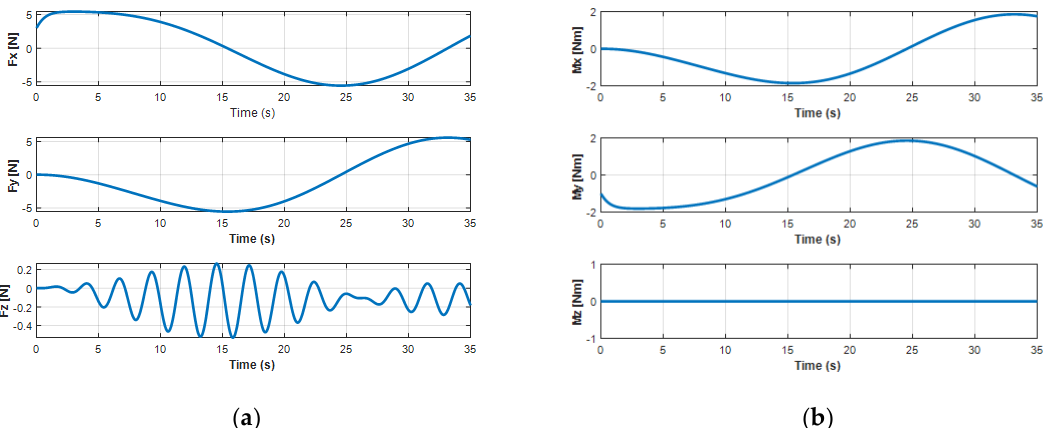
Figure 17. Cable forces and moments affecting UUV turning motion: ( a ) forces of the UC on the UUV; ( b ) moments of the UC on the UUV.